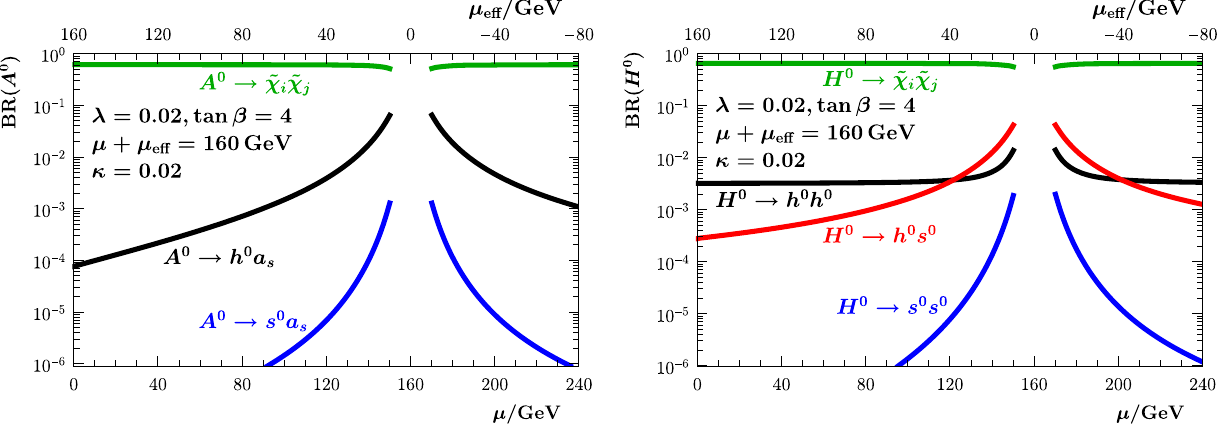
Fig. 11 Branching ratios of A 0 (left) and H 0 (right) into pairs of lighter Higgs bosons; both for the same scenario as in Fig.9. The branching ratios BR ( A 0 → ˜ χ i ˜ χ j ) and BR ( H 0 → ˜ χ i ˜ χ j ) include all kinematically allowed channels into pairs of neutralinos and